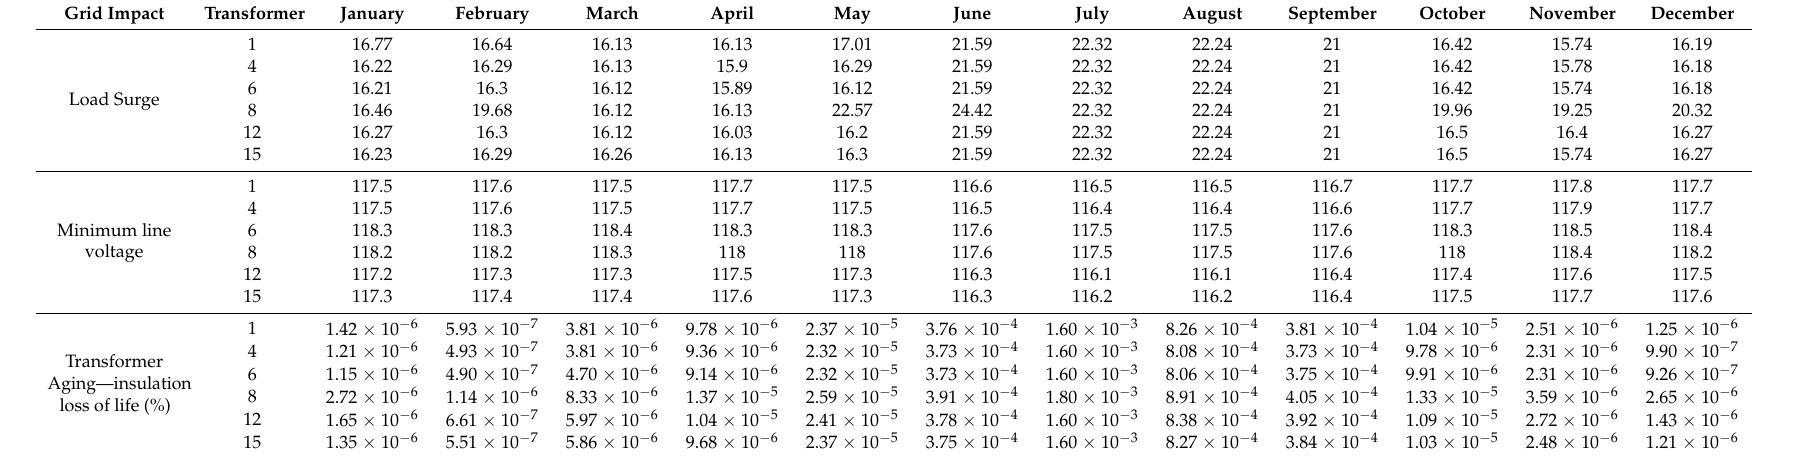
Table A4. Summary of the impact of ToU + DLC+ optimal PEV charging in 12